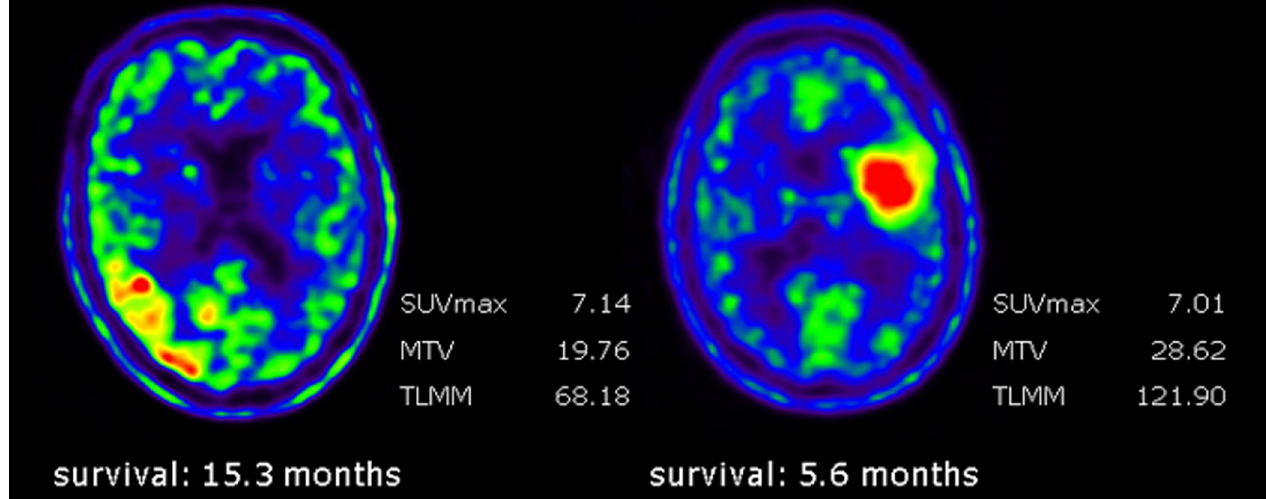
Fig 3. Differences in metabolic and volumetric parameters in two glioblastoma patients. Left image: 52-year-old male with right temporoparietal glioblastoma. Right image: 47-year-old male with left frontal glioblastoma. Despite relatively similar SUVmax values, there was a significant difference in survival between the two patients. The tumor of the patient on the right side demonstrated higher MTV and TLMM values than the tumor on the left side, corresponding to the lower survival of this patient.